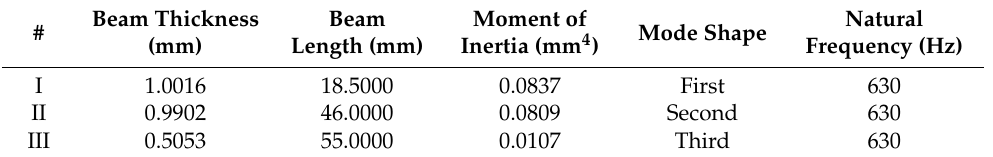
Table 2. Specifications of piezoelectric